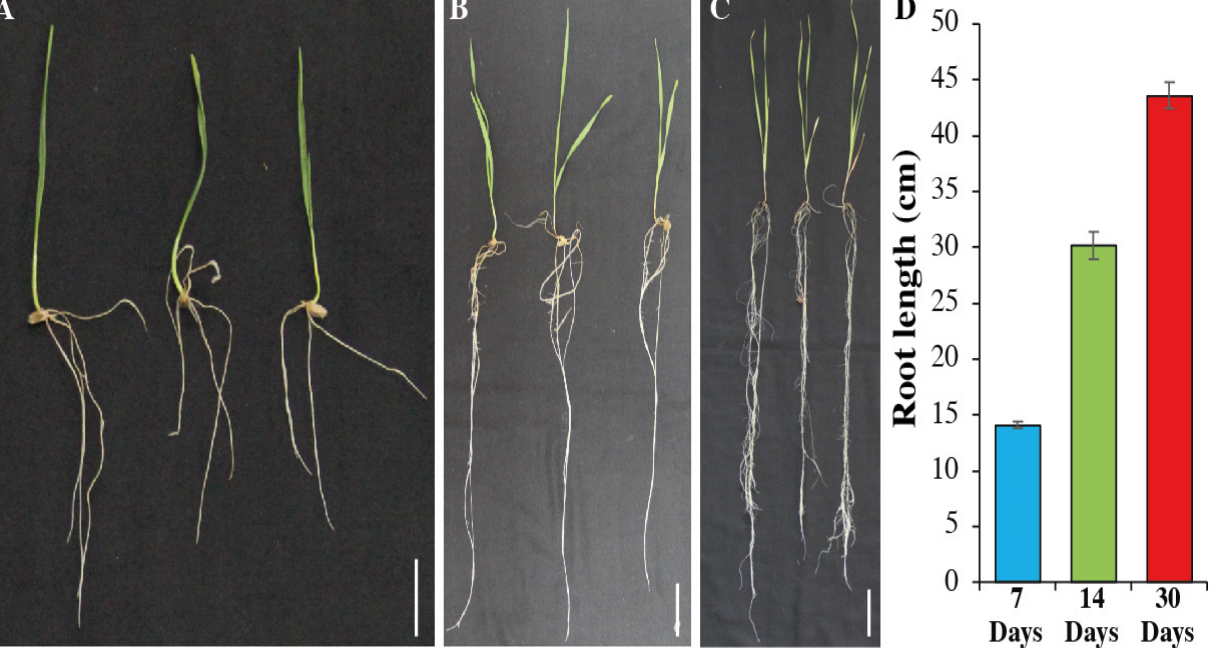
Table 1. Summary of total and clean reads from 18 comparative libraries.